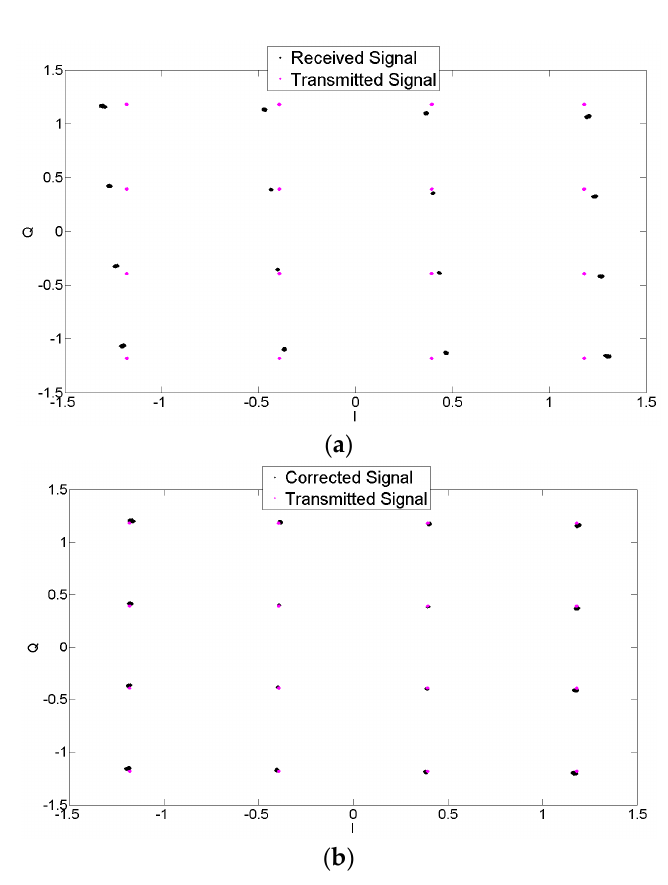
Figure 13. Measured output and post compensated signal.